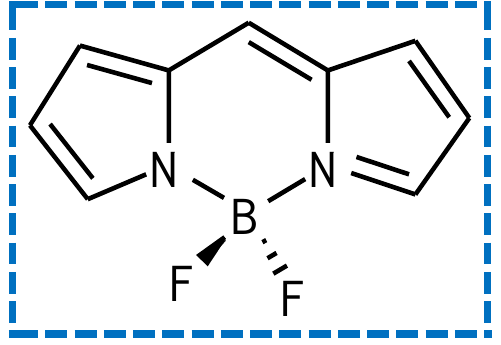
Figure 20. General structure of boron dipyrromethene dyes.